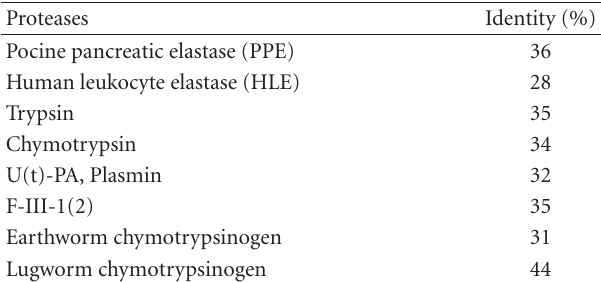
Table 6: Comparison of homologous sequences with some serine